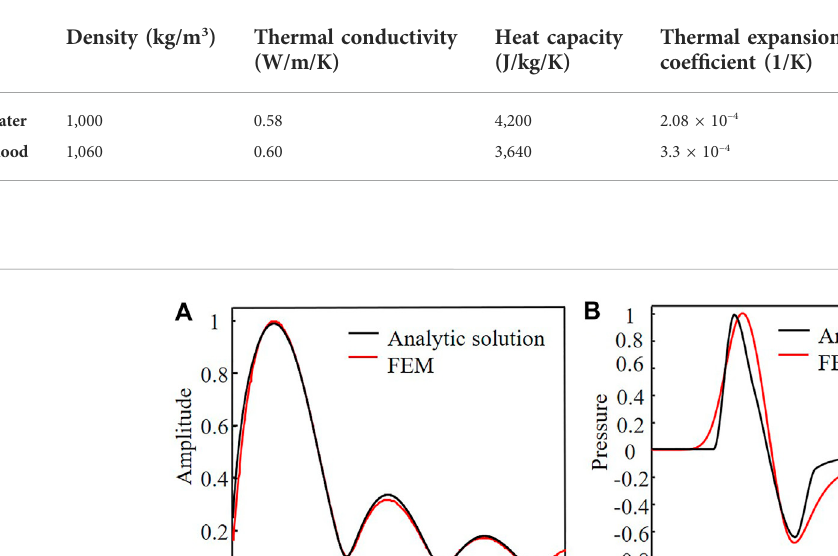
TABLE 1 Parameters have been used for PA FEM